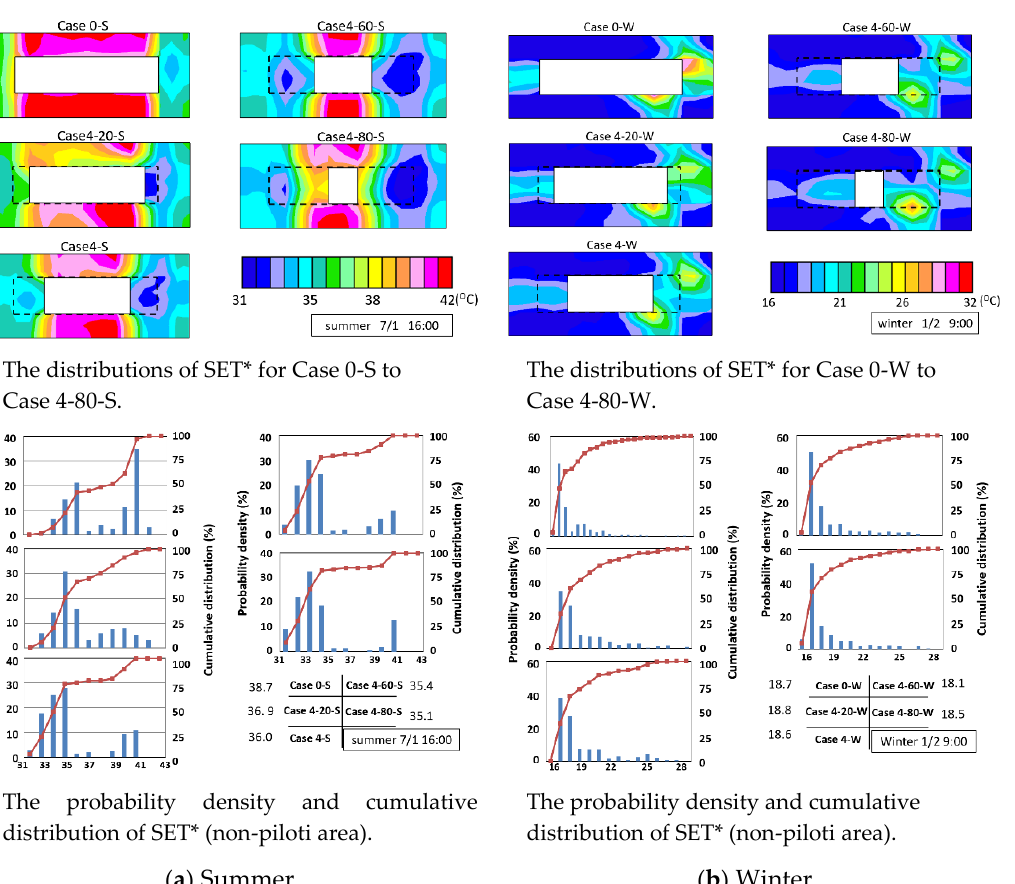
Figure 14. The simulation results of SET*.